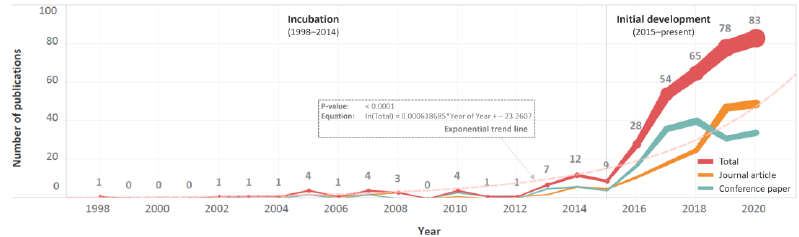
Figure 2. Annual distribution of publications, 1998–2020.